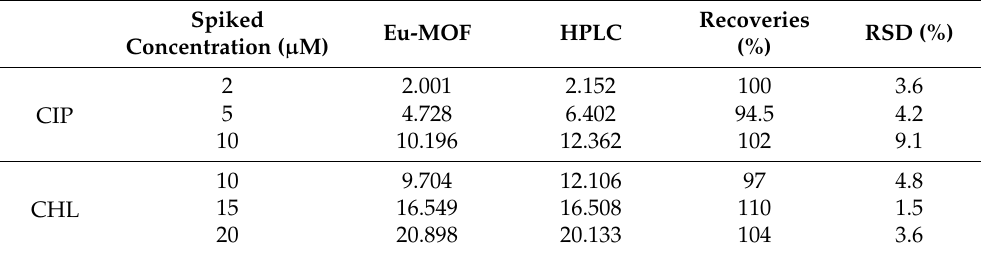
Table 2. Detection of CIP and CHL in Spiked Milk